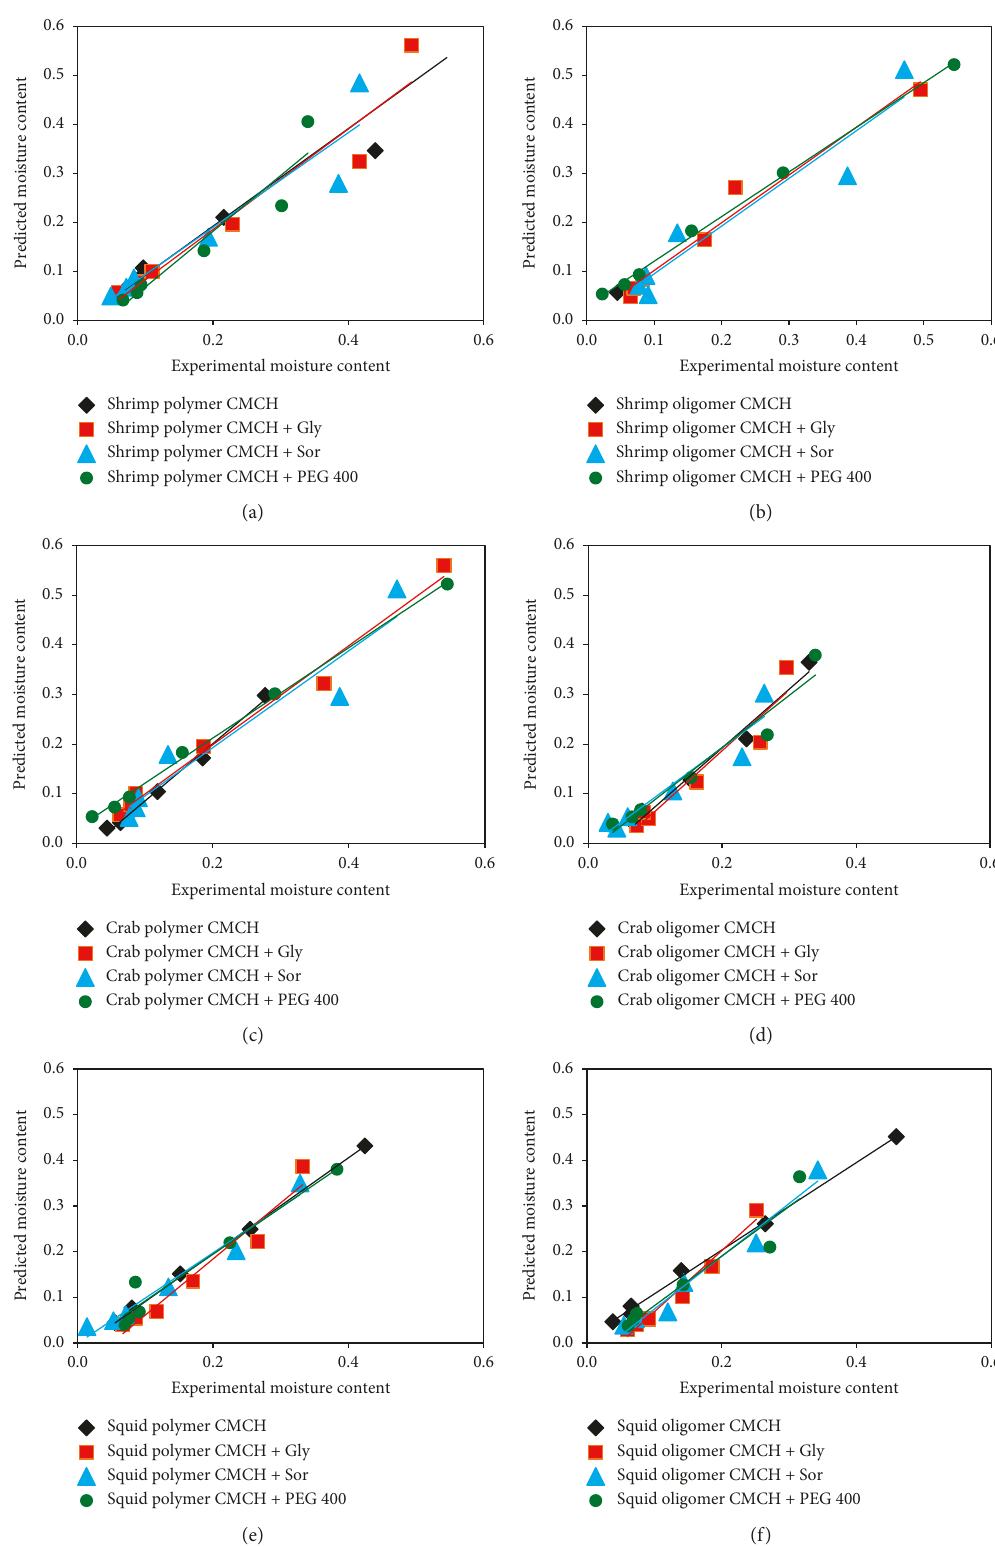
Figure 8: The comparison between the experimental moisture content values and those predicted for all the CMCH films from the Hasley model: shrimp polymer CMCH films (a); shrimp oligomer CMCH films (b); crab polymer CMCH films (c); crab oligomer CMCH films (d); squid polymer CMCH films (e); squid oligomer CMCH films